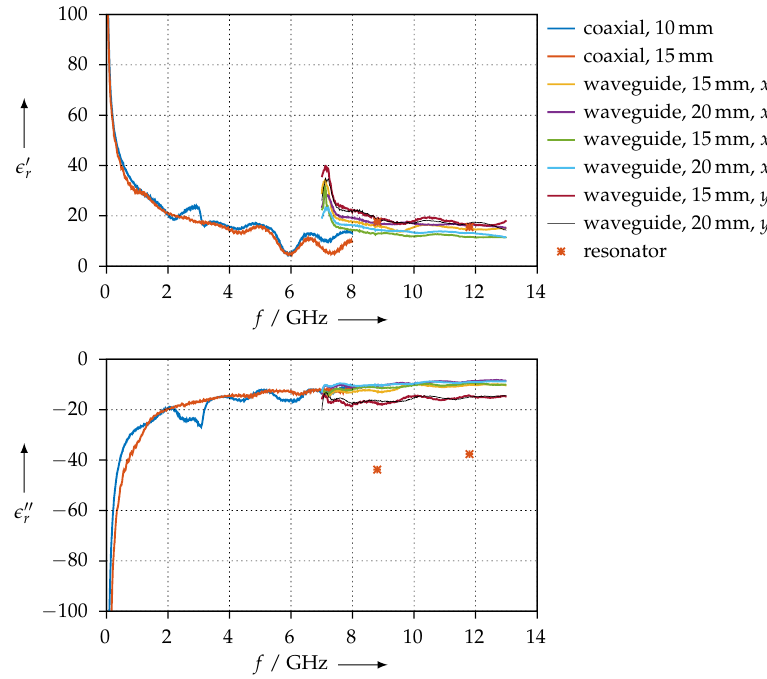
Figure 25. Real ( (cid:101) (cid:48) r ) and imaginary ( (cid:101) (cid:48)(cid:48) r ) parts of the permittivity for the CDP material for different